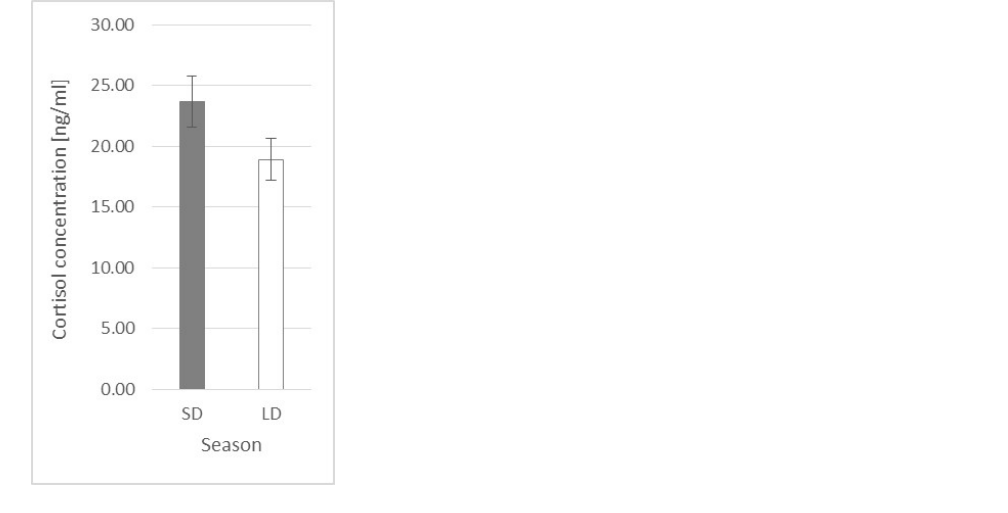
5 of 24 Figure 3. Plasma leptin concentration—comparison among the experimental groups (Control, LPS, LEP and LPS + LEP) for short-day (SD) ( A ) and long-day (LD) ( B ) photoperiod for each selected time point separately; A–D—bars with different letters differ significantly within each time point according to the two-way analysis of variance (ANOVA) followed by Fisher’s post-hoc test ( p ≤ 0.05) ( n = 6). Groups: control—saline injection, LPS—lipopolysaccharide injection at a dose of 400 ng/kg of body mass at a 0 h time point, LEP—leptin injected at a dose of 20 μ g/kg of body mass at a 0.5 h time point, LPS + LEP—LPS and LEP injections at the same doses and time points as those in the